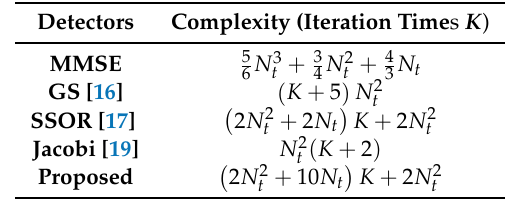
Table 2. Computational complexity comparison.